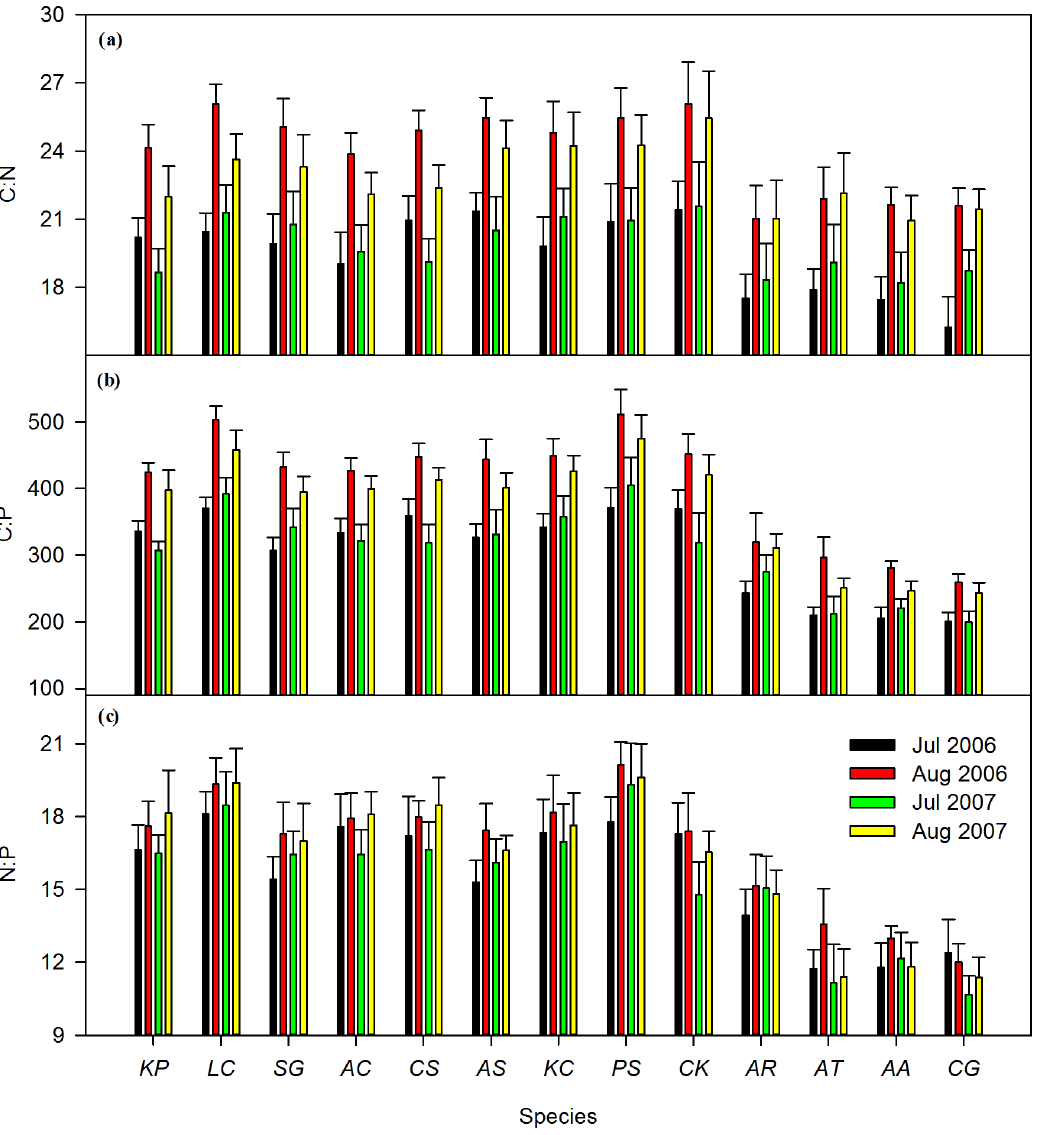
Figure 3. C:N, C:P, N:P ratios of 13 Inner Mongolia grassland dominate and common species with four sampling dates during two- year field N and P addition experiment. KP Kochia Prostrate, LC Leymus chinensis , SG Stipa grandis , AC Agropyron cristatum , CS Cleistogenes squarrosa , AS Achnatherum sibiricum , KC Koeleria cristata , PS Poa sphondylodes , CK Carex korshinskyi , AR Allium ramosum , AT Allium tenuissimum , AA Axyris amarantoides , CG Chenopodium glaucum . Error bars are